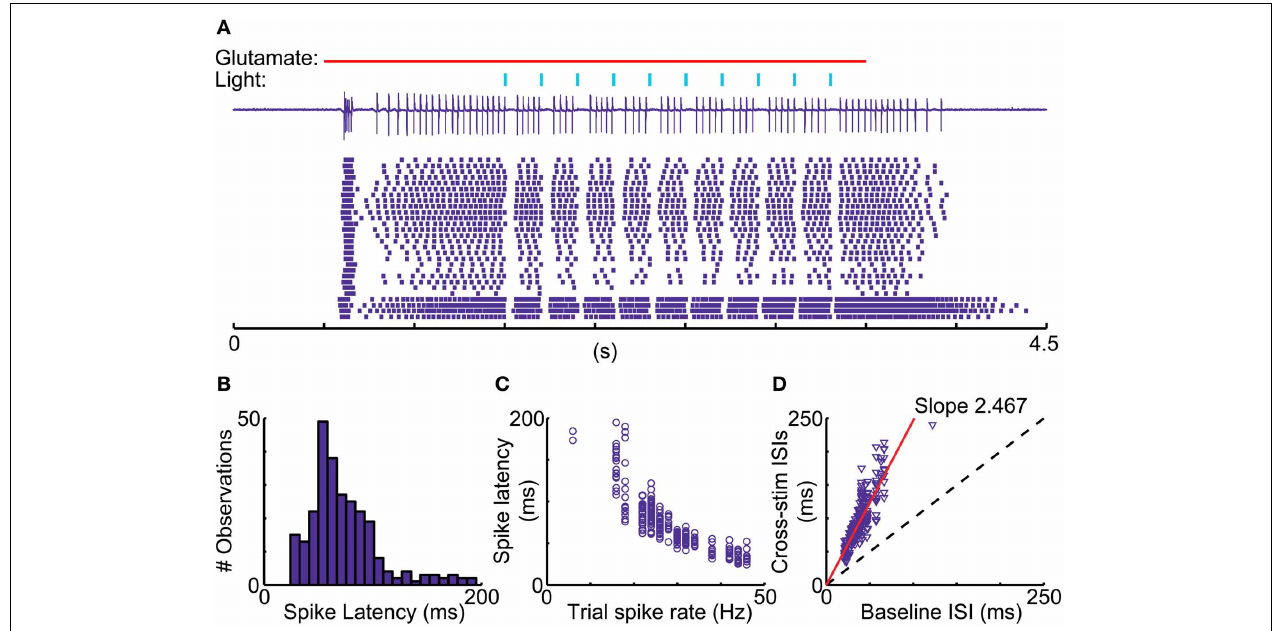
FIGURE 8 | Variable duration of spike pauses with nigral IPSP. (A) Sample cell-attached current trace and raster plot of 28 stimulus repetitions for a 5Hz train of 10ms light pulses during glutamate excitation. Note the lack of alignment of the first spike following pauses. (B) Latency histogram of first